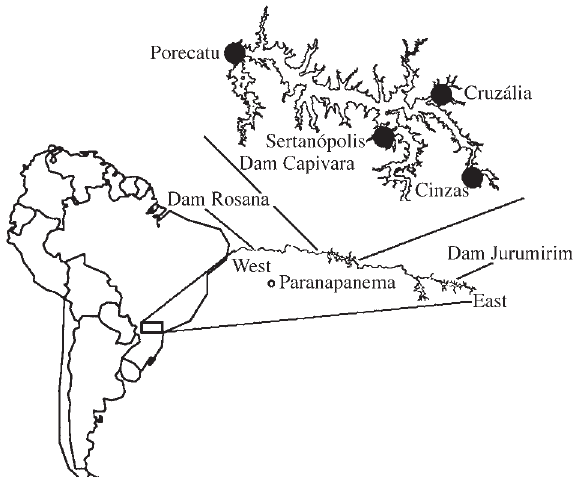
Figure 1 - Map of the River Paranapanema with designated collection